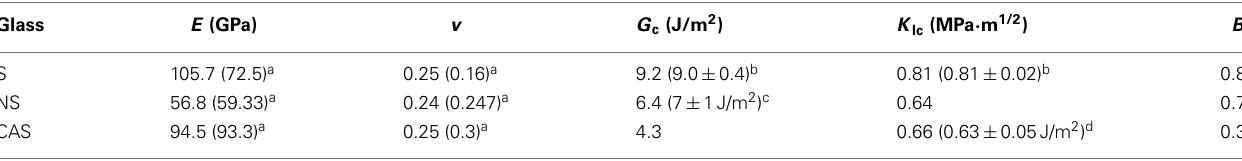
Table 1 | ComputedYoung’s modulus ( E ), Poisson’s ratio ( v ), fracture energy ( G C ), elastic fracture energy ( G el ), fracture toughness ( K Ic ), and